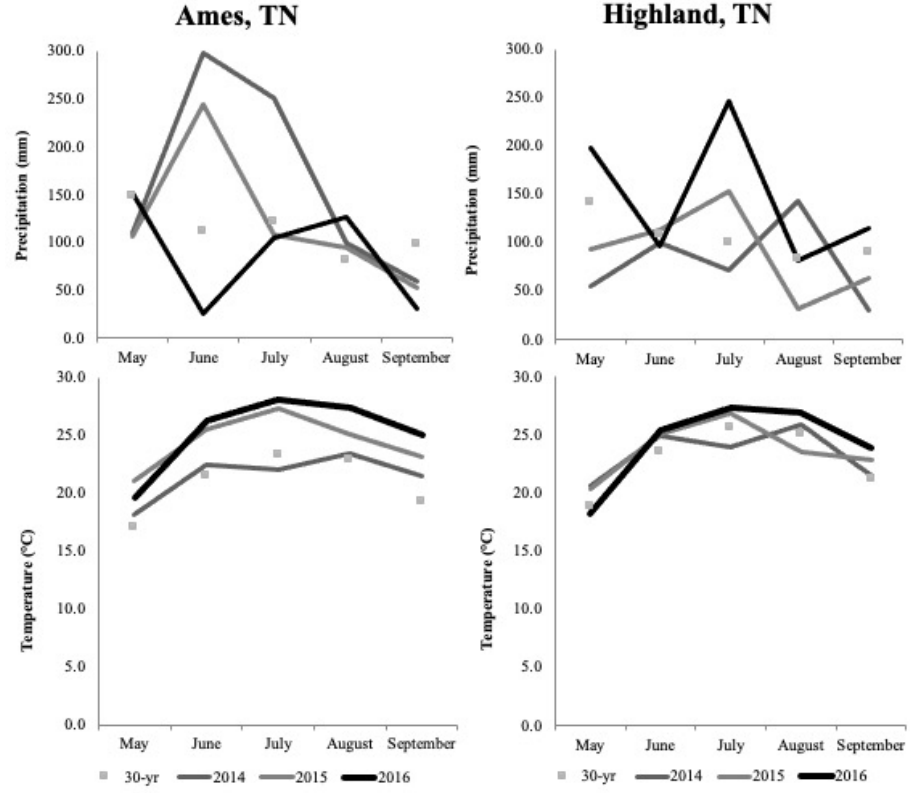
Figure 2. Monthly total precipitation and average monthly temperature at Highland Rim AgResearch and Education Center, Springfield, TN and Ames Plantation AgResearch and Education Center, Grand Junction, TN, 2014–2016 and 30 year means.